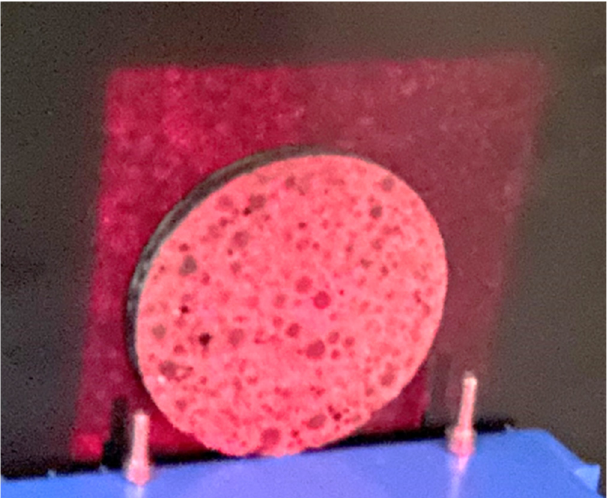
Figure 3. Photo of the heated area in relation to a circular specimen with 10 cm diameter (the area is illuminated by a red pilot laser).